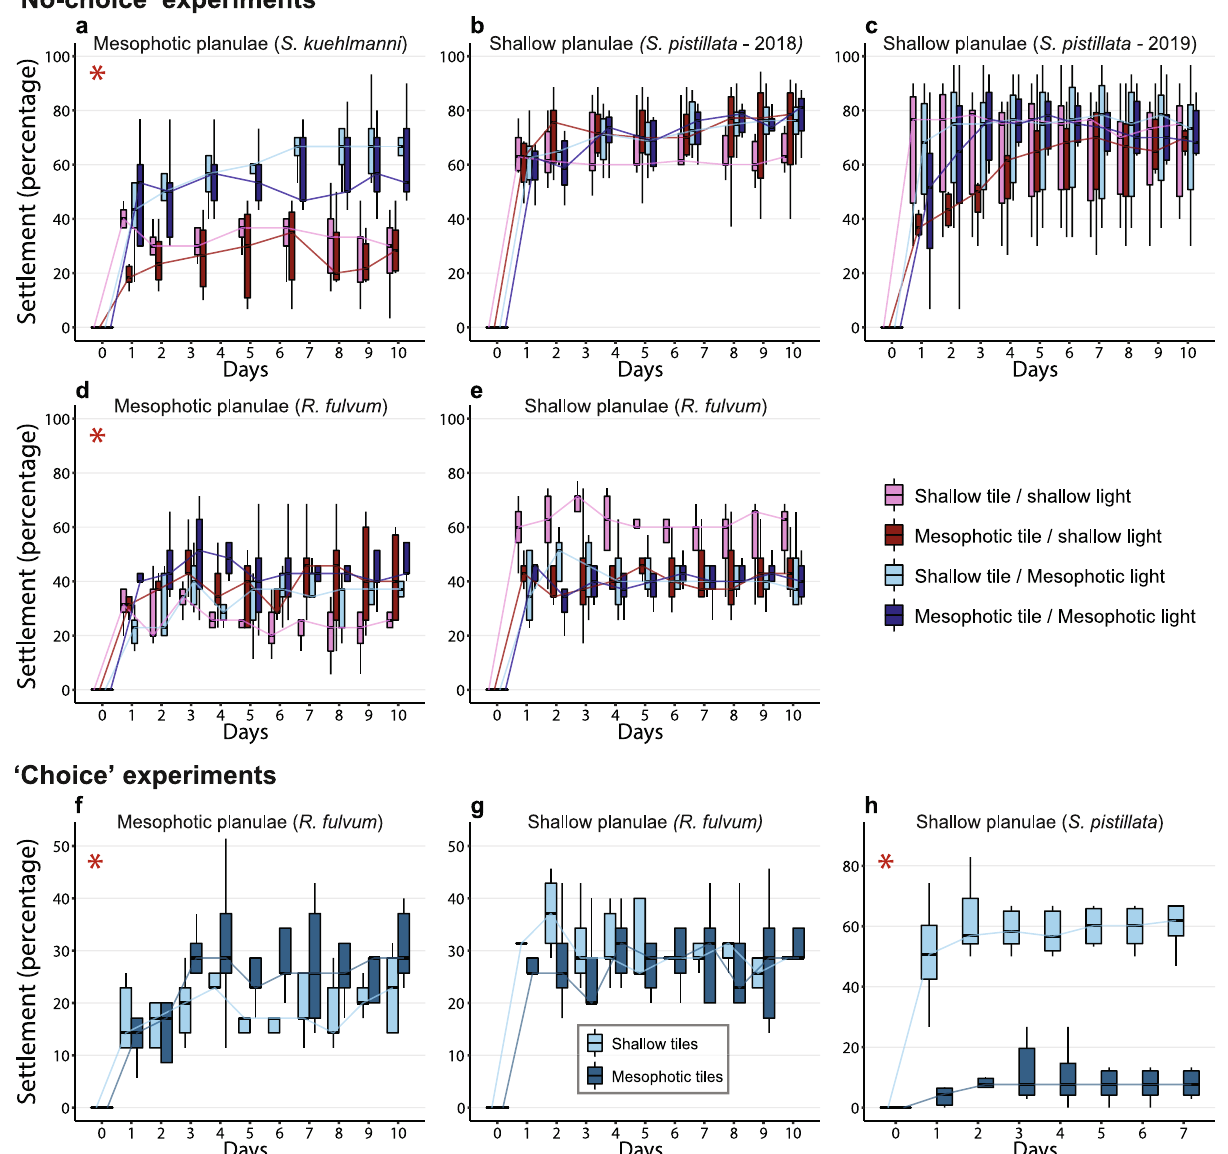
Fig. 2 Settlement of coral larvae originating from different depths and species. Box plots showing the settlement percentages in the “ no-choice ” ( a - e ) and “ choice ” ( f – h ) experiments (For every treatment group, n = 5 – 6 replicates containing 30 – 40 larvae each; for detailed account see Methods and Supplementary Data 1). Settlement percentages of a the “ deep-specialist ” species Stylophora kuehlmanni ; b shallow-originating larvae of the “ depth- generalist ” species Stylophora pistillata in 2018; c shallow-originating larvae of S. pistillata in 2019; d mesophotic-originating larvae of the “ depth-generalist ” species Rhytisma fulvum ; e shallow-originating larvae of R. fulvum ; f mesophotic-originating larvae of R. fulvum ; g shallow-originating larvae of R. fulvum ; and, h shallow-originating larvae of S. pistillata . Center lines of the box plots indicate the medians, boxes indicate the lower and upper quartiles, and whiskers indicate 1.5x interquartile range. Lines connect the medians of each treatment group to aid visualization and red asterisks indicate where signi fi cant differences were found between